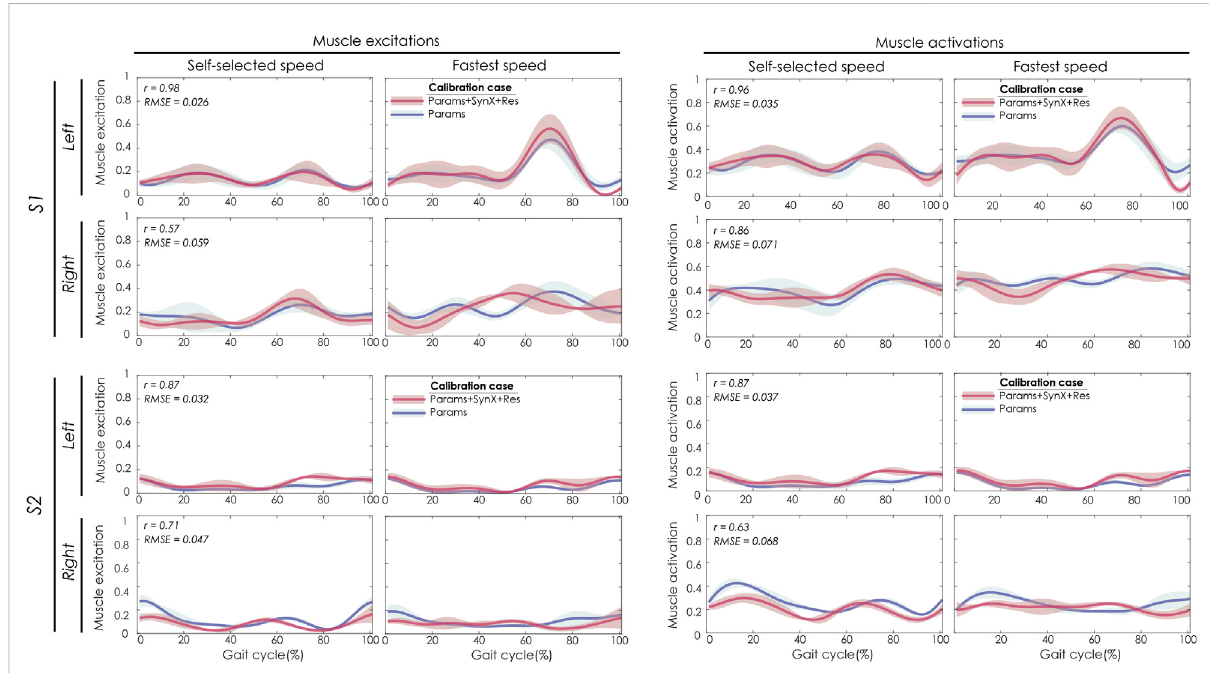
FIGURE 3 SynX-predicted muscle excitations and activations for psoas constructed with the best methodological combinations for the “ calibration ” situations (trial-speci fi c unmeasured and speed-speci fi c residual synergy vector weights with six synergies). Lines represent mean curves across calibration trials, and shaded areas represent ±1 standard deviation. r and RMSE values for muscle excitations and activations were calculated between “ Params+ SynX +Res ” calibration(in pink)and “ Params ” calibration(in blue). “ Params ” calibrationwasperformedusing acompleteset ofEMGsignals, wherenomuscleexcitationswerepredicted.Dataarereportedforthecompletegaitcycle,where0%indicatesinitialheel-strikeand 100% indicates subsequent heel-strike for each leg of both subjects (right leg: paretic, left leg: nonparetic). SynX-predicted muscle excitations and activations for iliacus were of similar